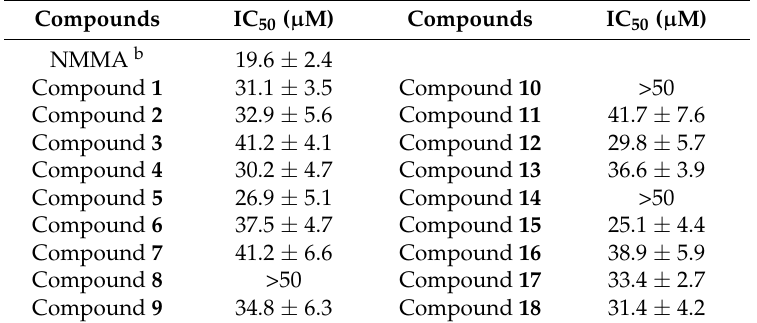
Table 2. Inhibitory on NO production in LPS-induced RAW 264.7 cells of compounds 1 – 18 . Compounds IC 50 ( µ M)